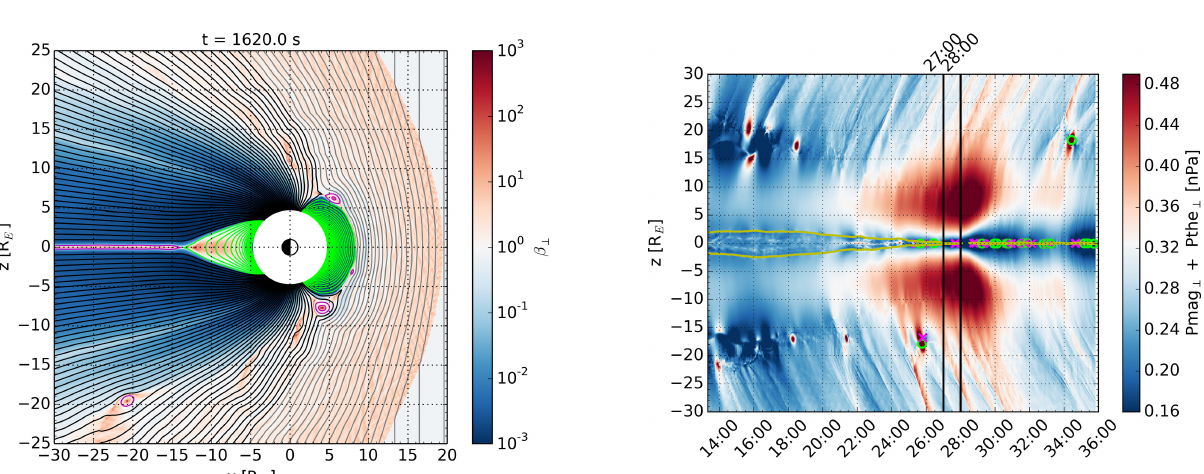
Figure 2. Sum of magnetic pressure and thermal ion pressure per- pendicular to the magnetic field at x = − 13 R E and y = 0 as a func- tion of z and time in minutes after the beginning of the simula- tion (MM:SS). The approximate onset times of lobe reconnection at 27:00 and fast flows at 28:00 are indicated by the black vertical lines. The yellow curves show the boundaries of the plasma sheet, identified as the region near the equatorial plane where plasma β ⊥ ≥ 1. Magenta crosses and green circles show the locations of X and O points,